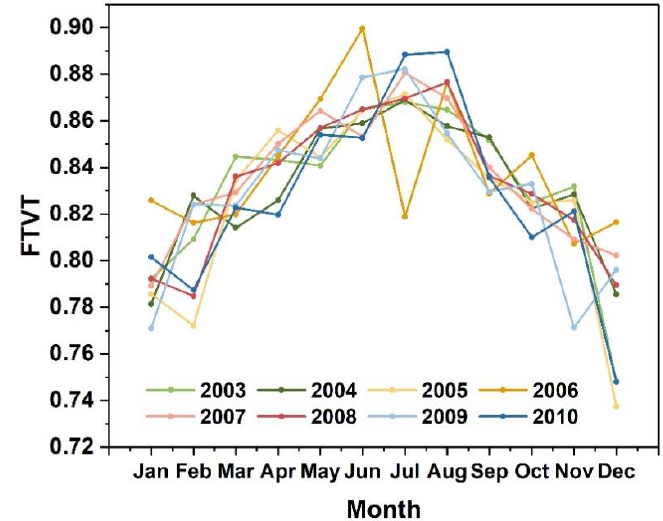
Figure 7. Seasonal variation of FTVT from 2003 to 2010. Table 1. Statistics of monthly FTVT from 2003 to 2010.